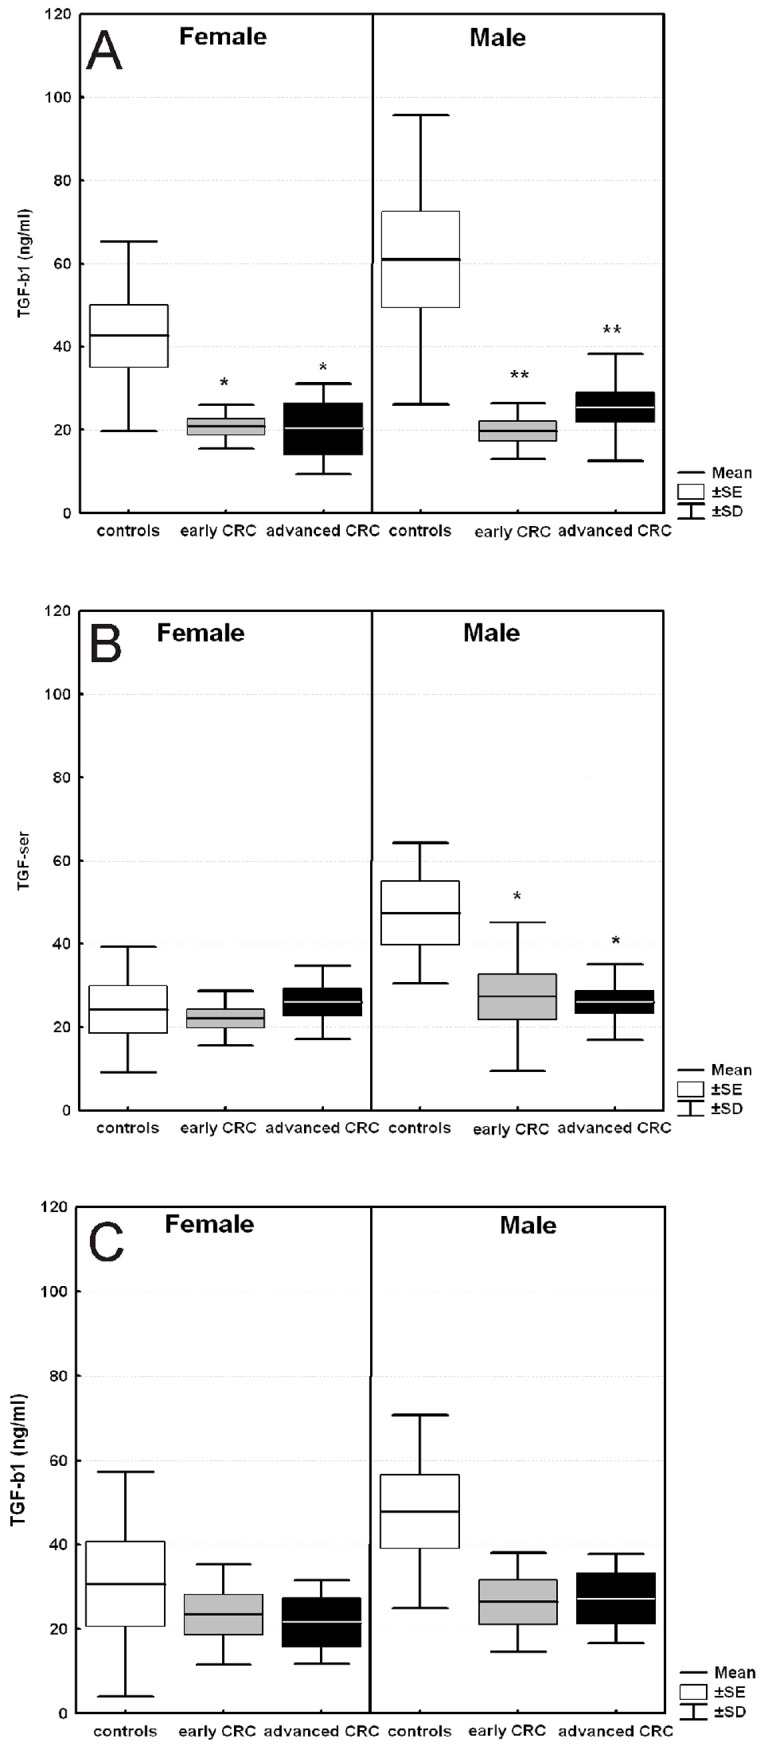
Serum levels of TGF-β1 in cases and controls over the age of 50 yrs.(A) Male and female carriers of TGFB1 -509CC genotype. (B) Male and female carriers of TGFB1 -509CT genotype. (C) Male and female carriers of TGFB1 -509TT genotype. The results are presented as the mean value ±SE (box) and ±SD (whisker). * p-value < 0.05, ** p-value < 0.01.